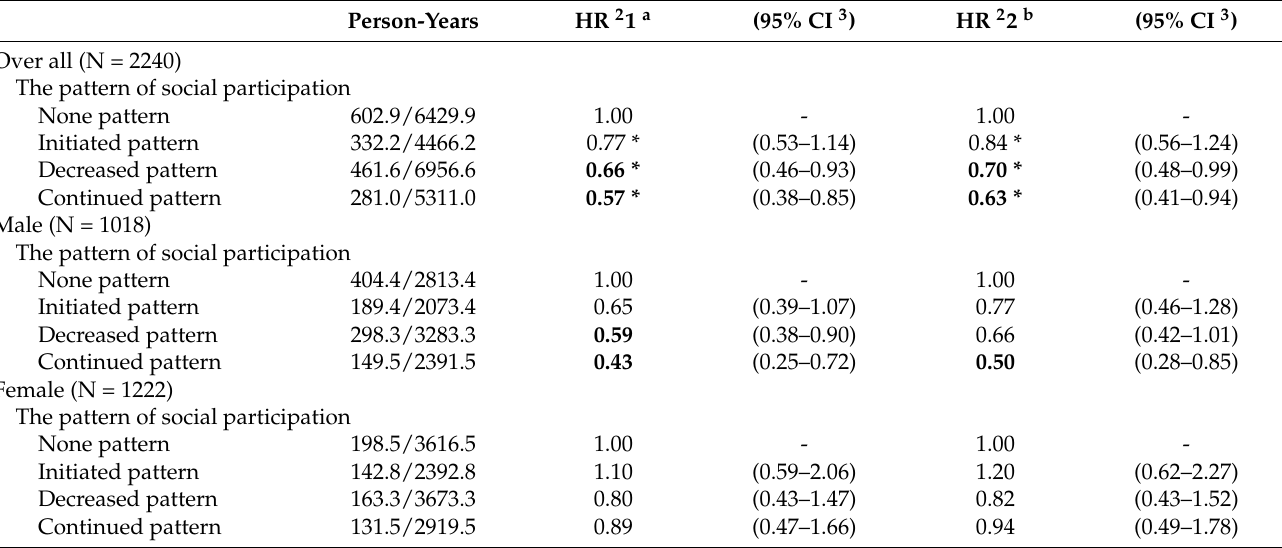
Table 3. Hazard ratios and 95% confidence intervals of all-cause mortality according to changes in the frequency of the pattern of social participation after imputing the MICE 1 .